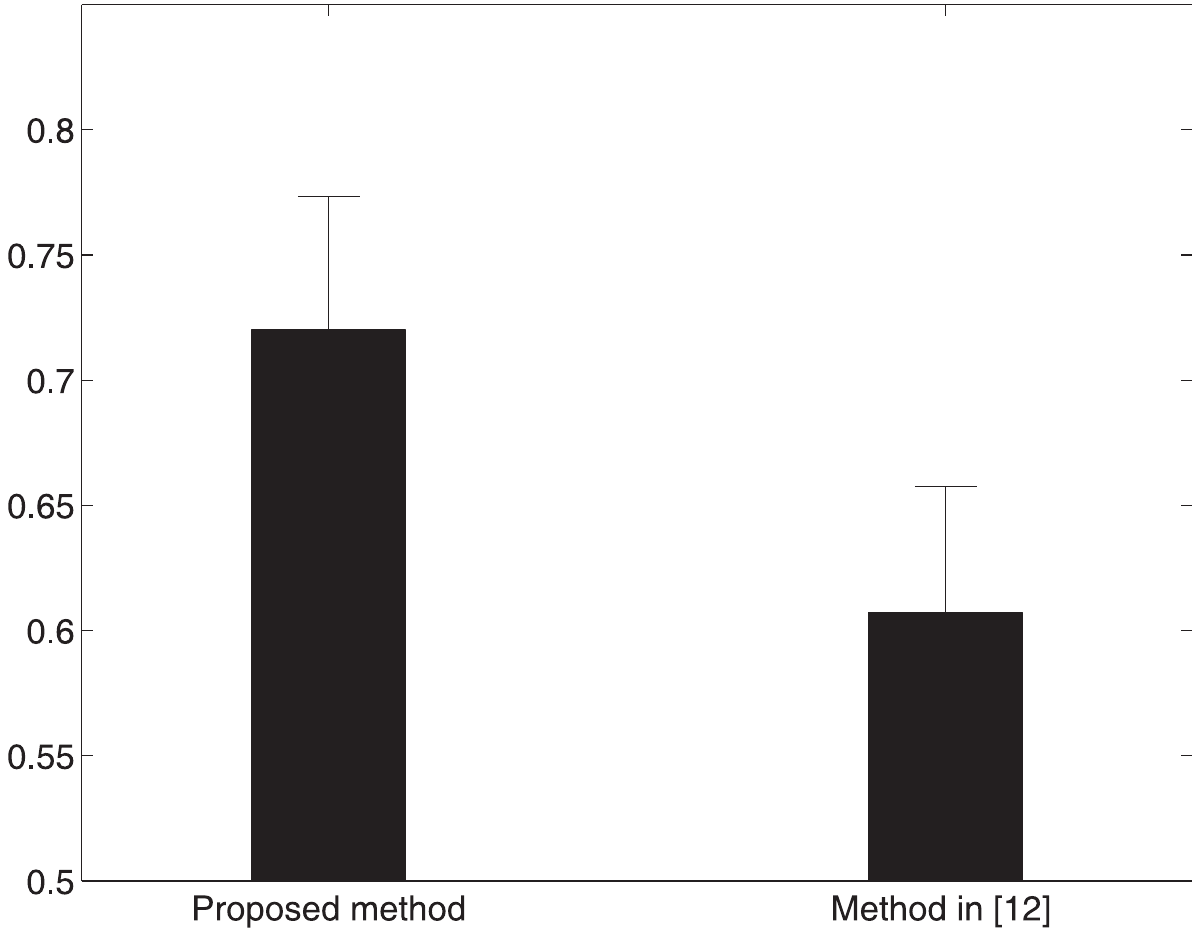
Figure 8. Comparison of decoding accuracy obtained by SVM with the proposed method (Left) and the method in [12] (Right). Clearly our approach provides higher decoding accuracy than that in [12].